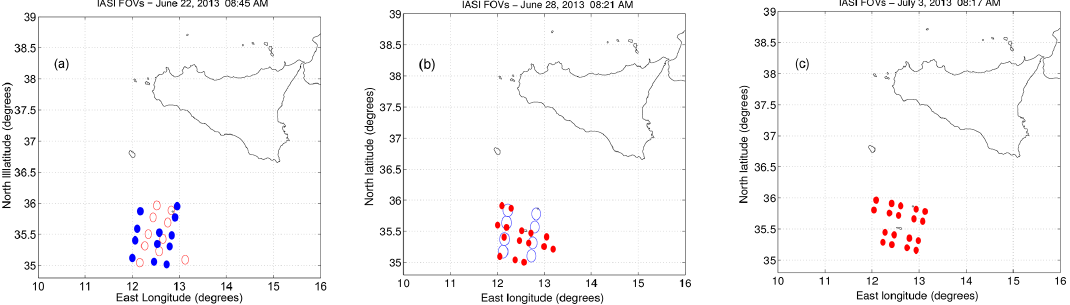
Figure 2. Location of the IASI fields of view analysed in this work. From left to right: 22 June, 28 June, and 3 July 2013. Red circles correspond to those acquired from IASI on board of MetOp-A, blue from IASI on board of MetOp-B. Filled footprints are those that have been effectively used, while those unfilled have not been exploited because of strong sunglint contamination in the shortwave. Table 2. From top to bottom: log-normal modes used to fit the observed size distributions on 22 June (top), 28 June (middle) and 3 July (bottom) for each altitude